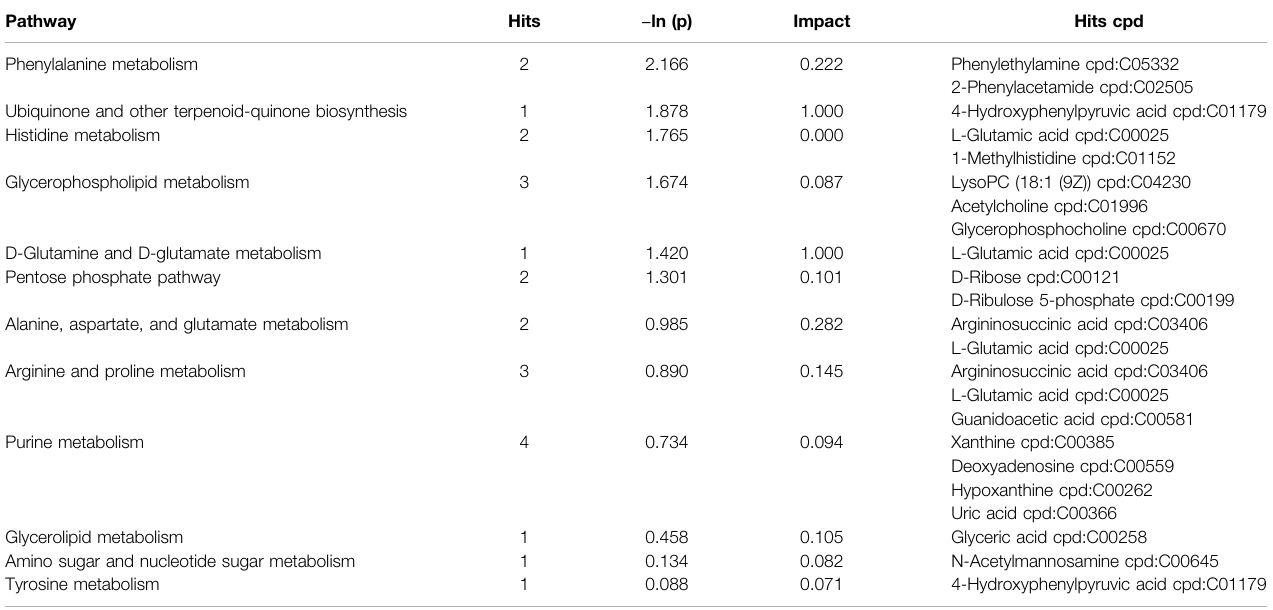
TABLE 2 | Metabolic pathways identi fi ed from the SDMs between EG1 and EG3. Pathway